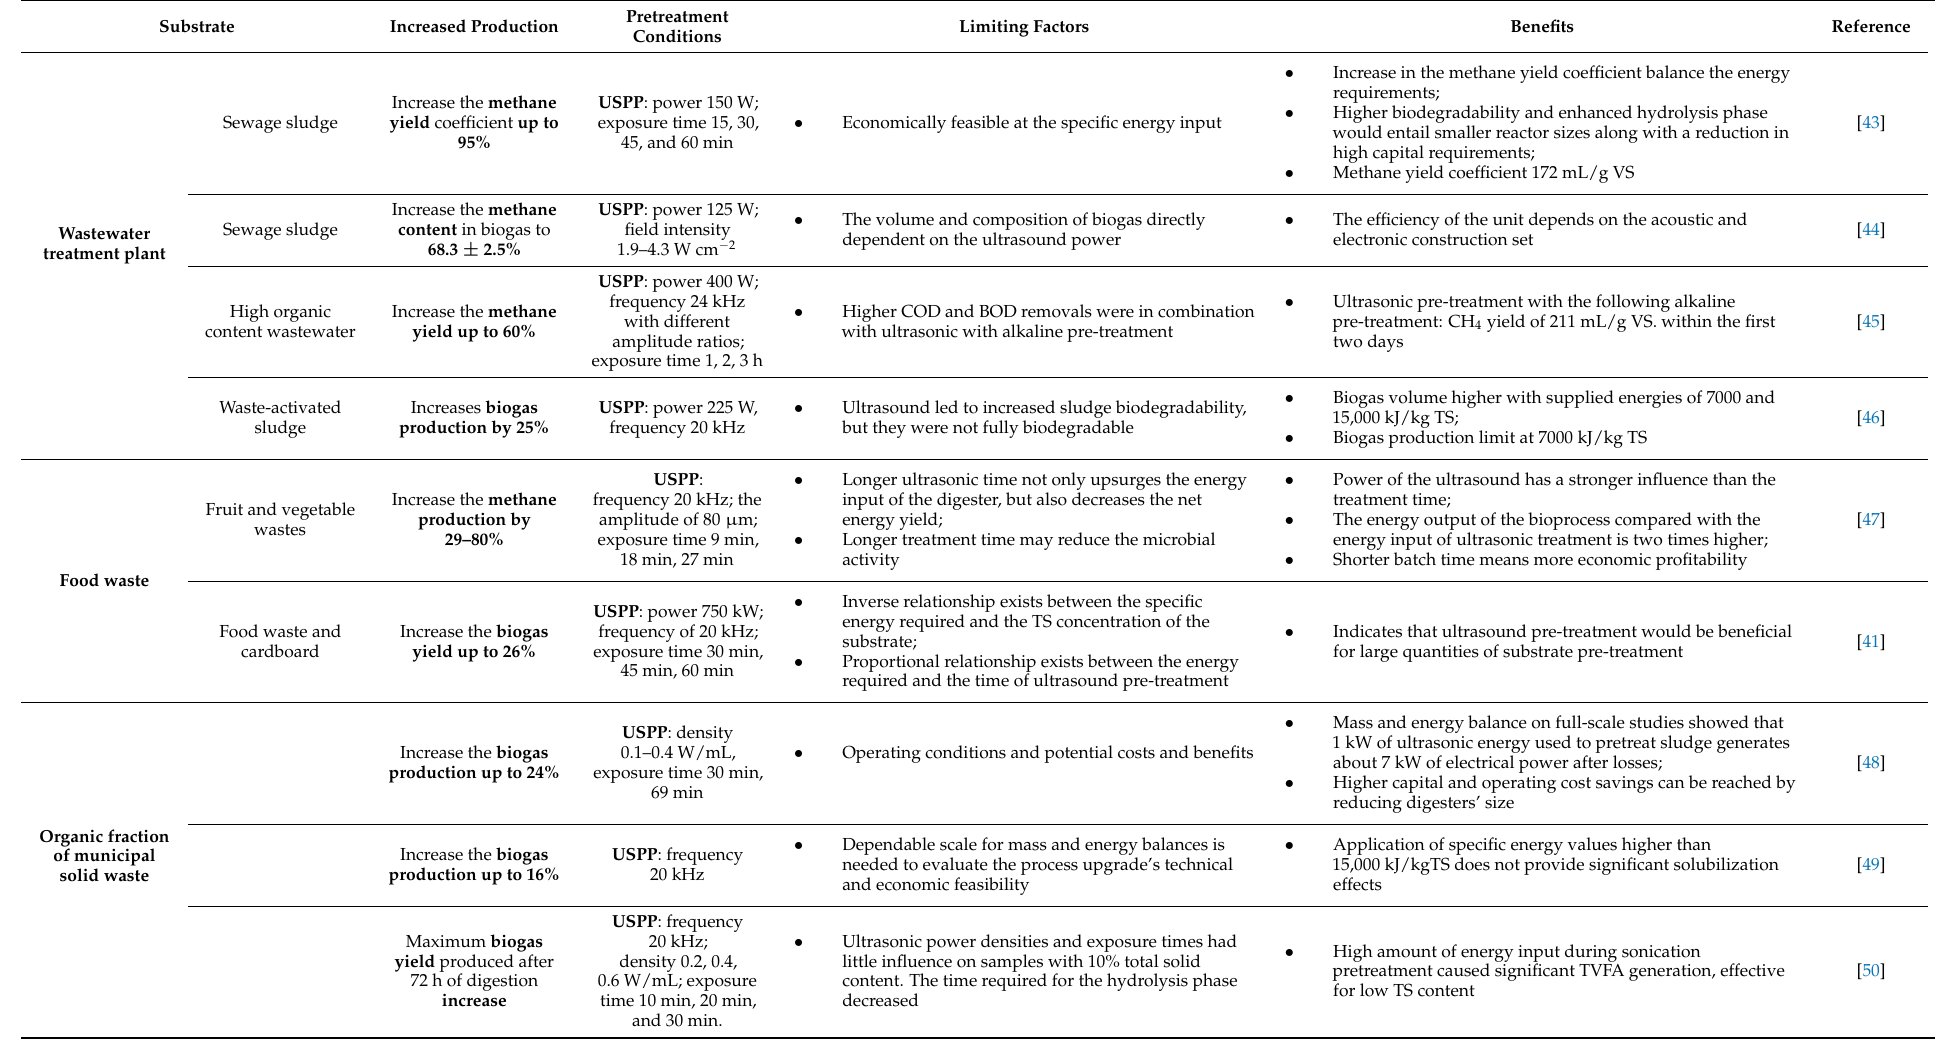
Table 1. Process characteristics with the additional